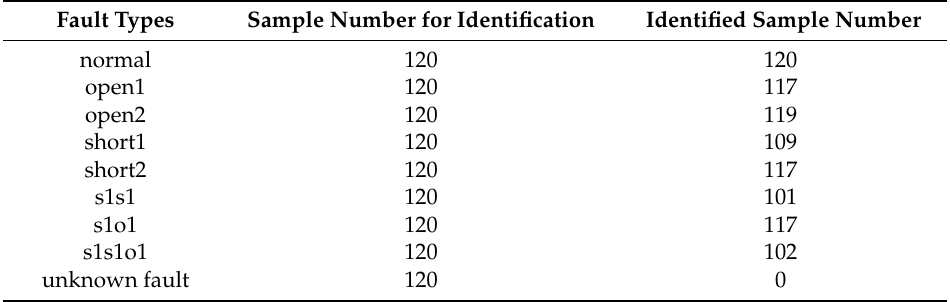
Table 8. Eight fault and an unknown fault identification accuracy in testing phase of the field experiment.